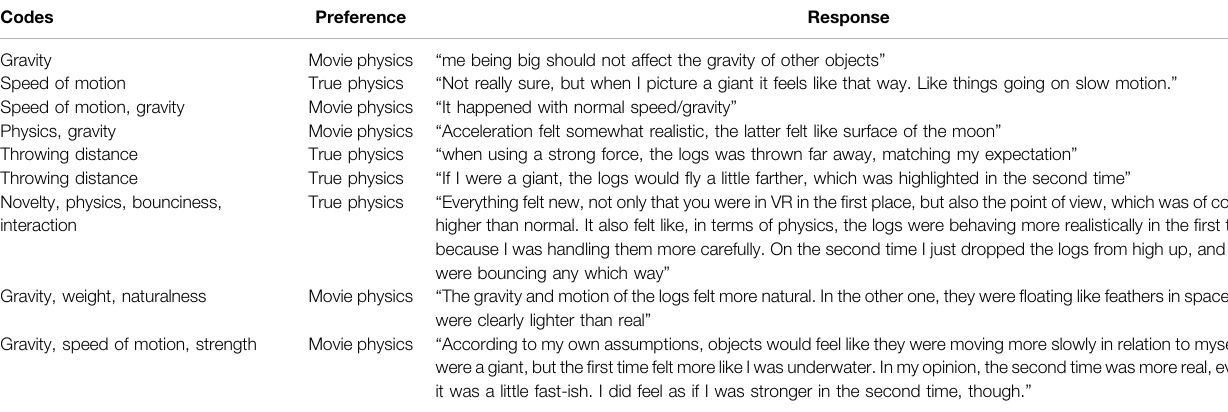
TABLE 4 | Examples of O1 responses (justi fi cation to realism ) in Study 2 Codes